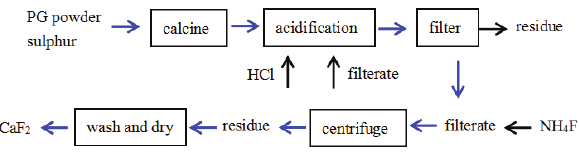
Figure 1: The process of calcium fluoride